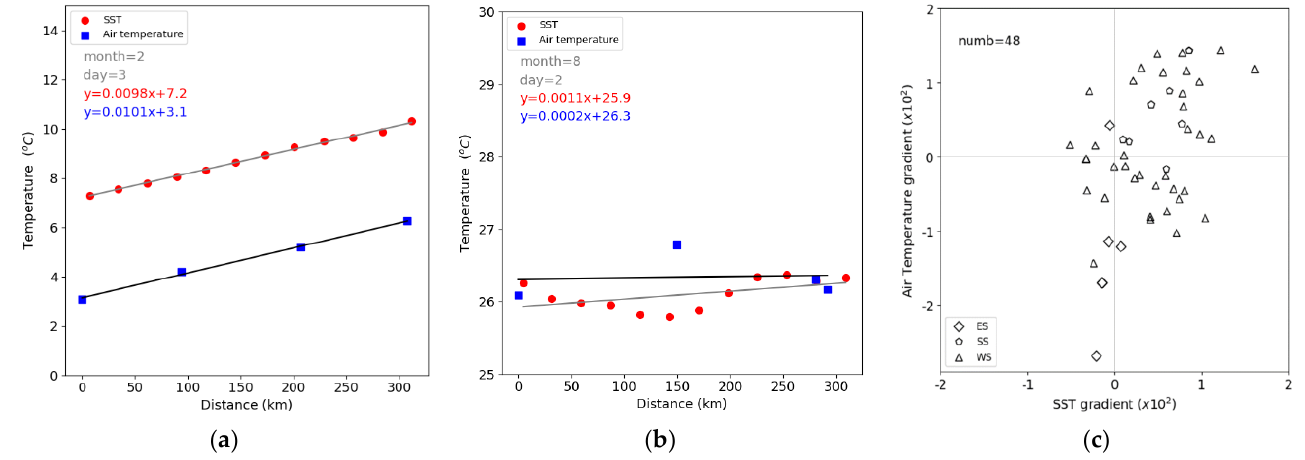
Figure 4. Variation in SST (red circle) and air temperature (blue square) along the flight path. The x-axis of ( a ) and ( b ) represents the distance from the initial launch point A of the dropsonde to the final point B over the West Sea. ( a ) 3 February 2021; ( b ) 2 August 2021; ( c ) the gradient of SST and air temperature.